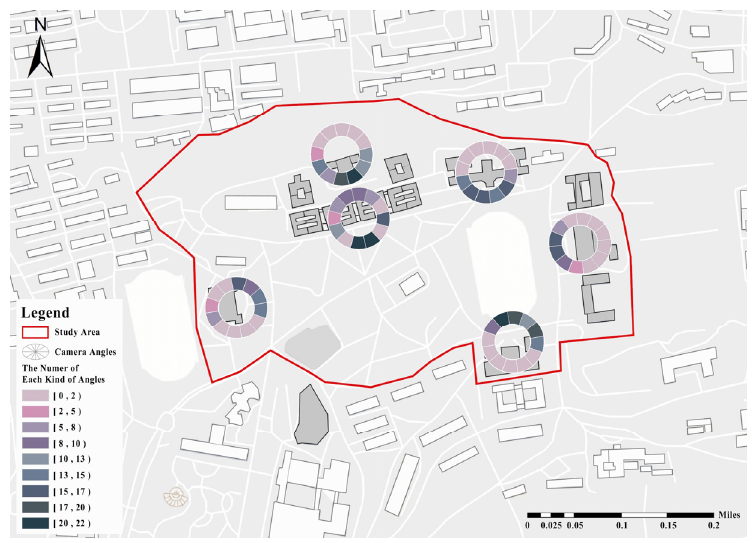
Figure 4. Analysis of landscape visual